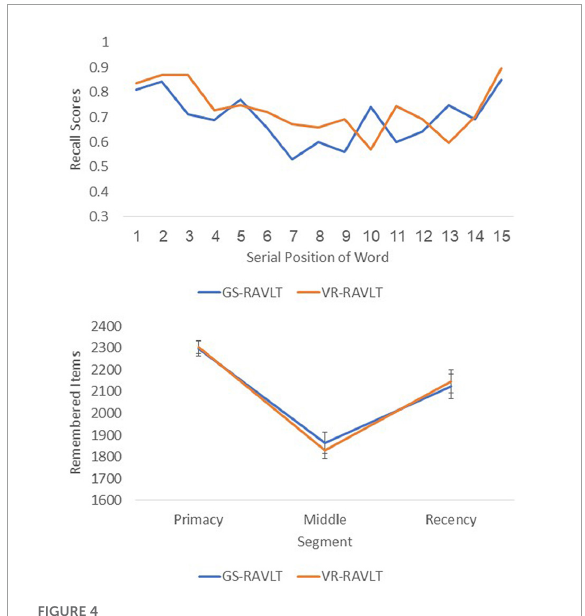
FIGURE4 A visual depiction of the Serial Position as a function of the serial positions (top) and the primacy and recency segments (bottom) for the gold standard-Rey Auditory Verbal Learning Test (GS-RAVLT) and the virtual reality adaptation of the Rey Auditory Verbal Learning Test (VR-RAVLT). The recall scores and the remembered items are collapsed across participants and age